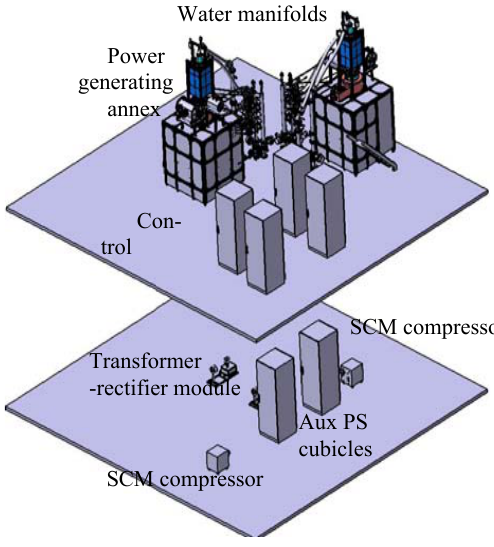
Fig. 1 Schematic view of gyrotron system components loca- tion at ITER